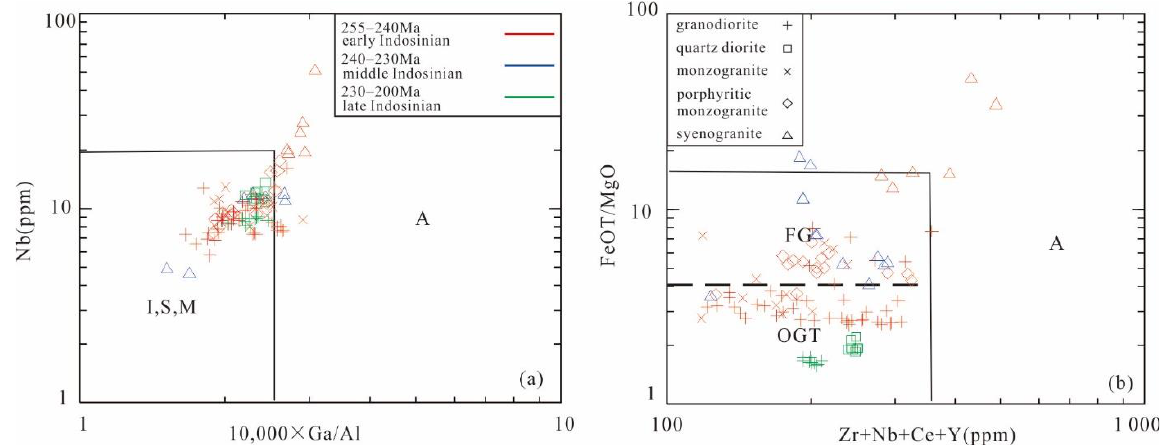
Figure 6. Diagrams of ( a ) 10,000 × Ga/Al vs. Nb and ( b ) (Zr + Nb + Ce + Y) vs. FeO T /MgO, for the Indosinian granite in the eastern region of the EKO (after [45]). FG = fractionated granites; OGT = unfractionated M-, I-, and S-type granites.